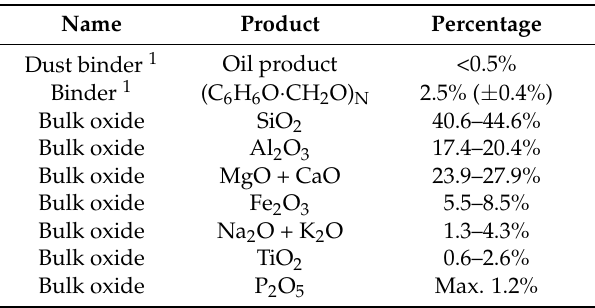
Table A3. Data for the thermal insulation studied (Rockwool ProRox PSM 971, 50 mm)